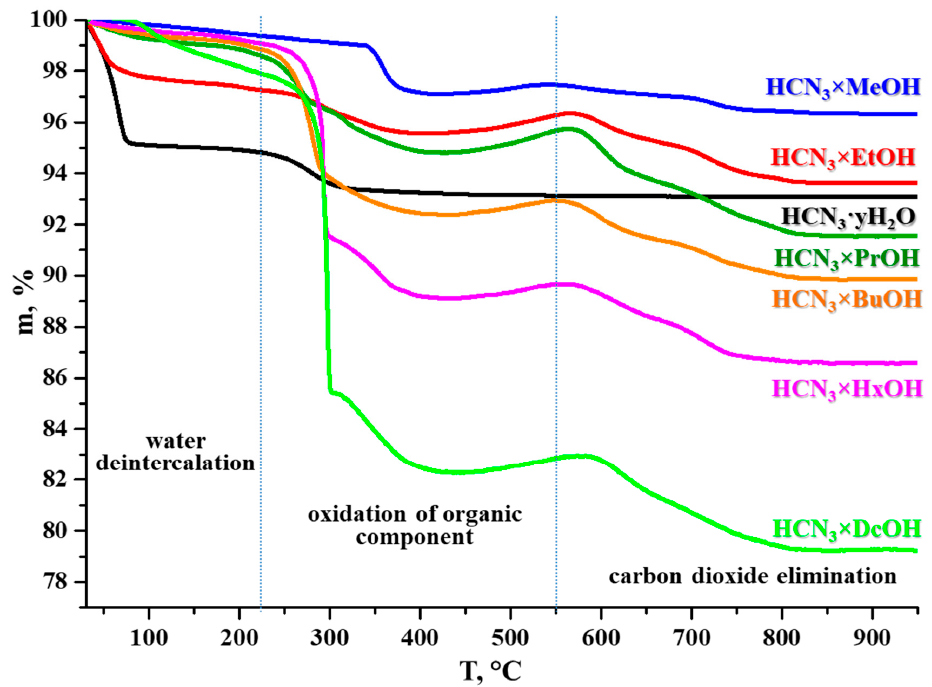
Figure 6. TG curves of the protonated niobate and its n -alkoxy derivatives. All the n -alkoxy hybrids obtained were tested for vacuum stability. This study was necessary in connection with the use of BET and SEM methods involving deep evacuation of the samples being analyzed. The results of the CHN-analysis of initial and vacuum- cured inorganic–organic samples (Supporting information S2) showed that the organic content in most of them preserves even after long keeping under deep vacuum (1·10 − 4 atm). The substantial loss in organic content ( ≈ 0.2 ethoxy groups per structural unit) was revealed for the ethoxy derivative. This fact may be due to the presence of residual loosely bound molecular ethanol (band at 58 ppm in the NMR spectrum) in the interlayer space that easily liberates under reduced pressure. Thus, the presence of intercalated ethanol explains not only the loss of a noticeable amount of the organic component under evacu- ation but also the large mass loss in the low-temperature region on the TG curve. All the hybrids were also tested for stability toward the hydrolysis of n -alkoxy groups in aqueous solutions (Supporting Information S3) that is the reverse reaction in relation to grafting and hypothetically should lead to the formation of the initial protonated niobate. Most of the hybrids (R = Et–Hx) after 1 d of water treatment noticeably change the appear- ance of their XRD patterns. However, even after 10 d of water treatment, complete coinci- dence of the hybrids’ patterns with that of the protonated niobate is not observed. The XRD patterns of many water-treated samples are generally similar to each other. The crys- tal structure of the methoxy derivative, which appeared to be the most stable toward the